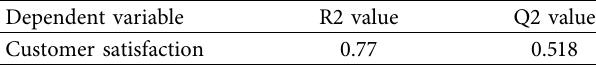
Table 7: R2 and Q2 values of the dependent variable.